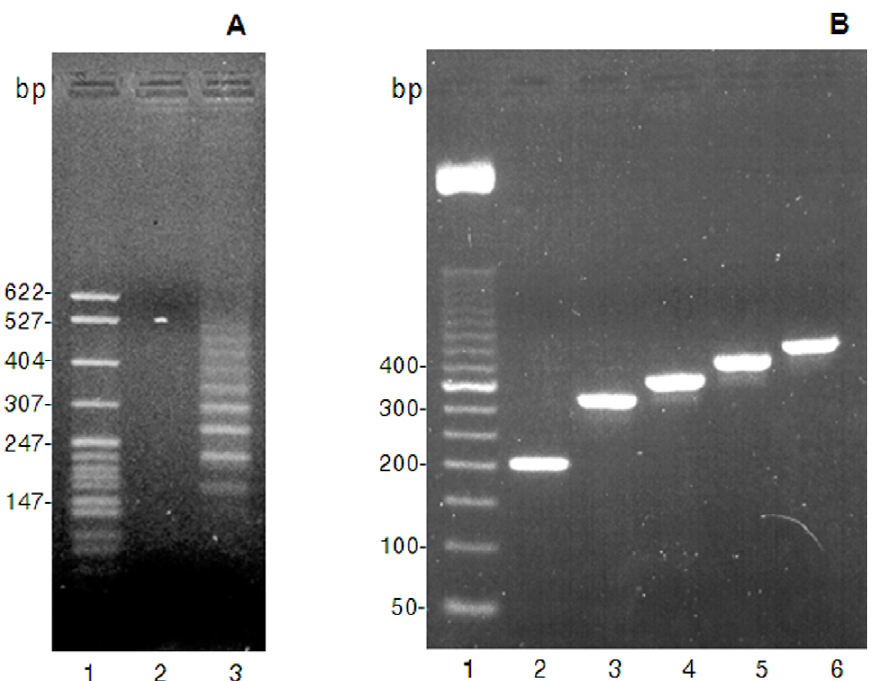
Figure 2. Analysis of recombinant histatin 3 constucts containing multiple functional domains on a 2% agarose gel. A, lane 1: pBR22- Hsp I marker; lane 2: empty; lane 3:16.5 m l of the final PCR reaction products. B, Analysis of inserts in histatin 3 constructs in pGEX-3X. Inserts were amplified using vector specific primers and an aliquot (1 m l) of each PCR reaction was analyzed on a 2% agarose gel. Lane 1, Gibco BRL 50 bp DNA ladder (6 m g); Lanes 2–6, PCR products of pGEX-3x, pHst3 1-mer, pHst3 2-mer, pHst3 3-mer, and pHst3 4-mer, respectively. doi:10.1371/journal.pone.0051479.g002 were investigated with the Friedman test (1-sided), with a level of